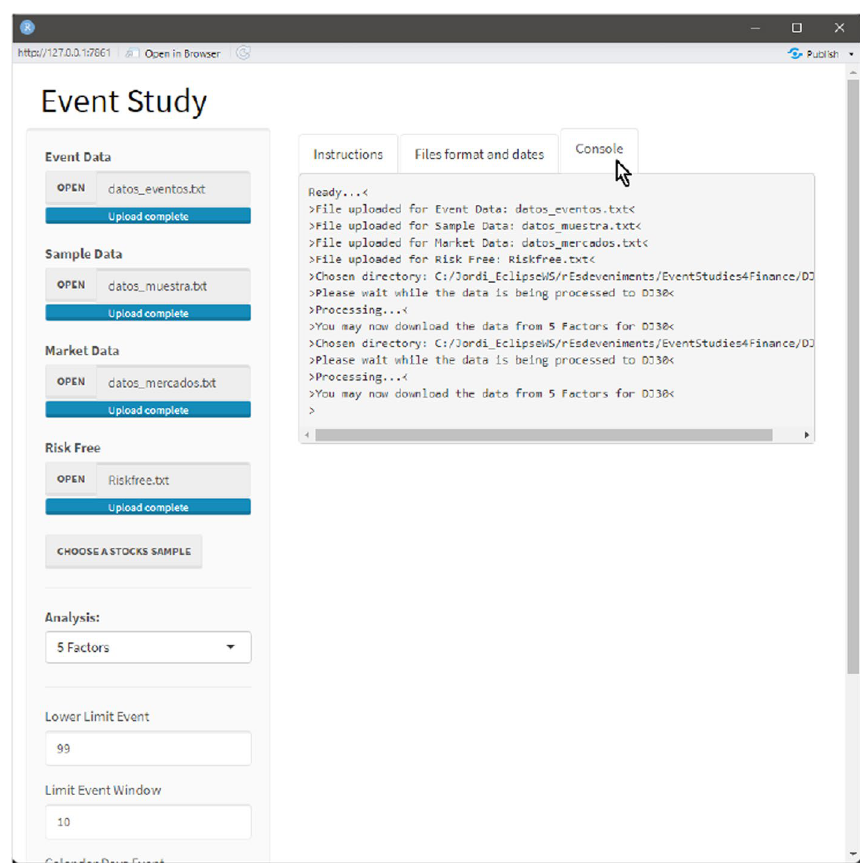
Fig. 18 Console tab. Source : Created by